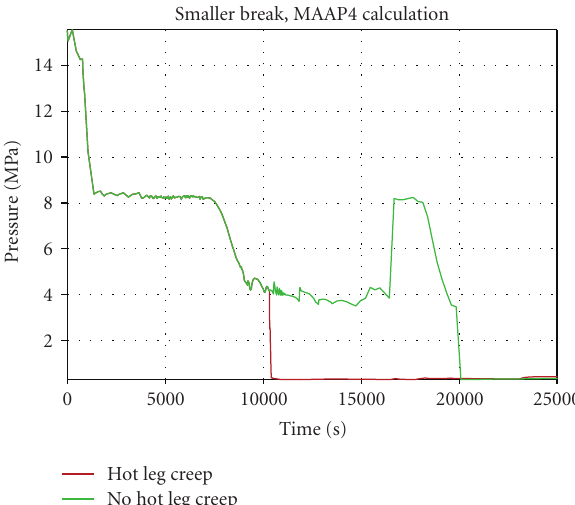
Figure 6: Core maximum temperature, MAAP4 calculation, Group 1.